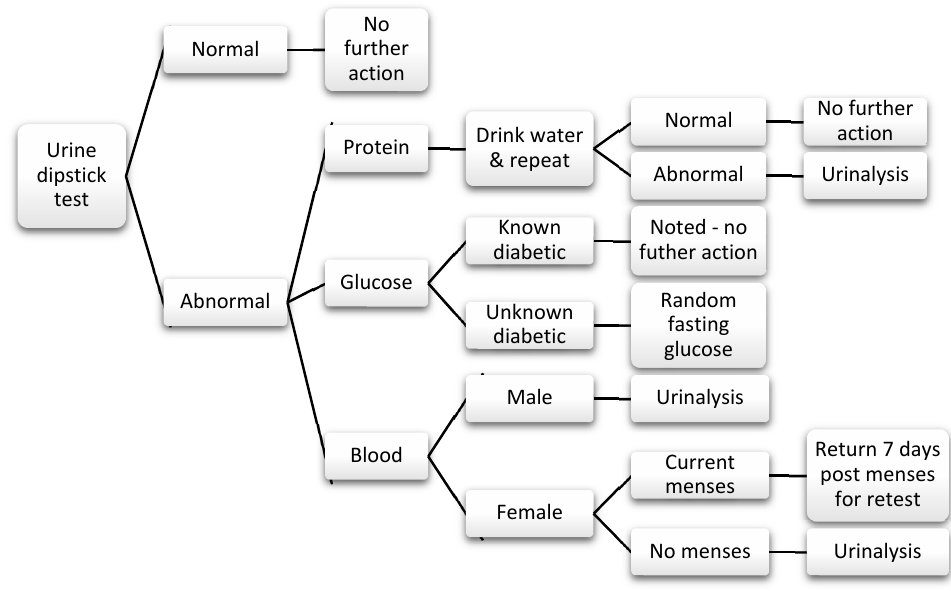
Figure 2. Urinalysis protocol.